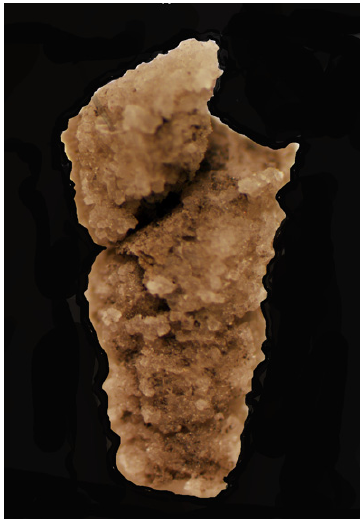
Figure 8. Abyssochrysoid gastropod (IGM 5010b). This view shows the last whorl separating slightly from the previous whorl, forming a channel.